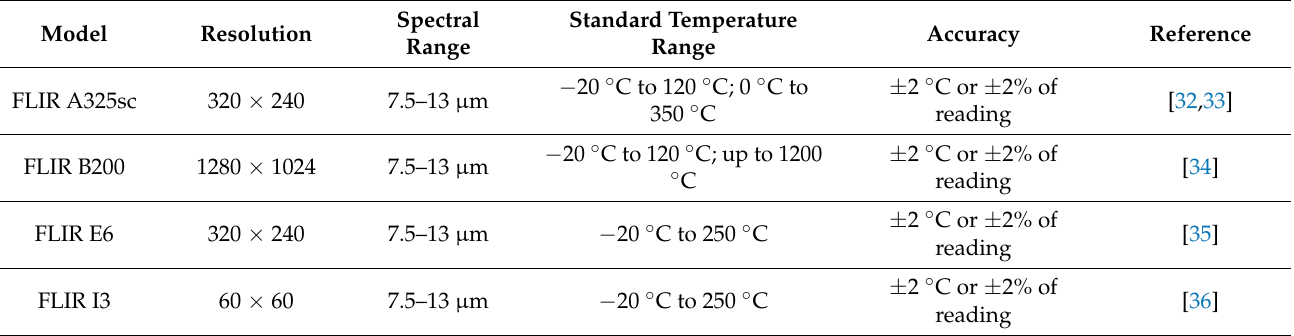
Table 1. The different models of thermography devices employed in the included